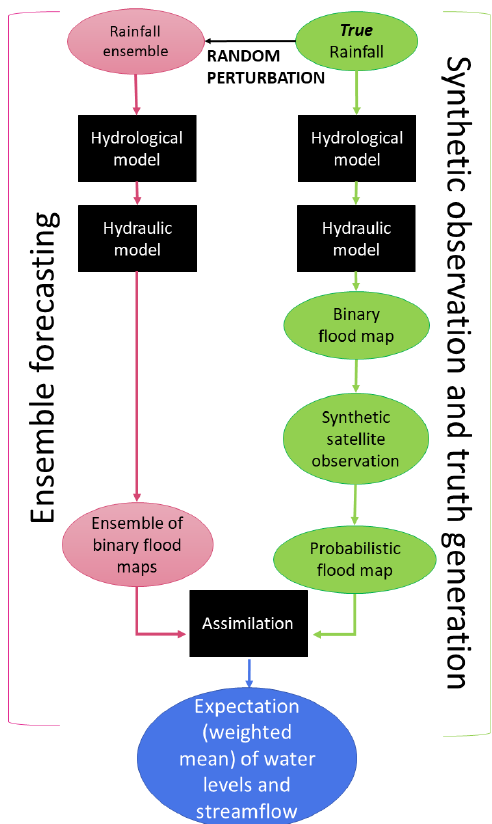
Figure 1. Flow chart of the synthetic experiment. The true rainfall is perturbed. The same flood forecasting model structure composed of a hydrologic model and a hydraulic model is used to obtain the probabilistic flood map and the ensemble of binary flood maps. The probabilistic flood map is assimilated into the ensemble of binary flood maps via the particle filter to obtain the weights with which the expectation of water levels, streamflow, and flood extents are